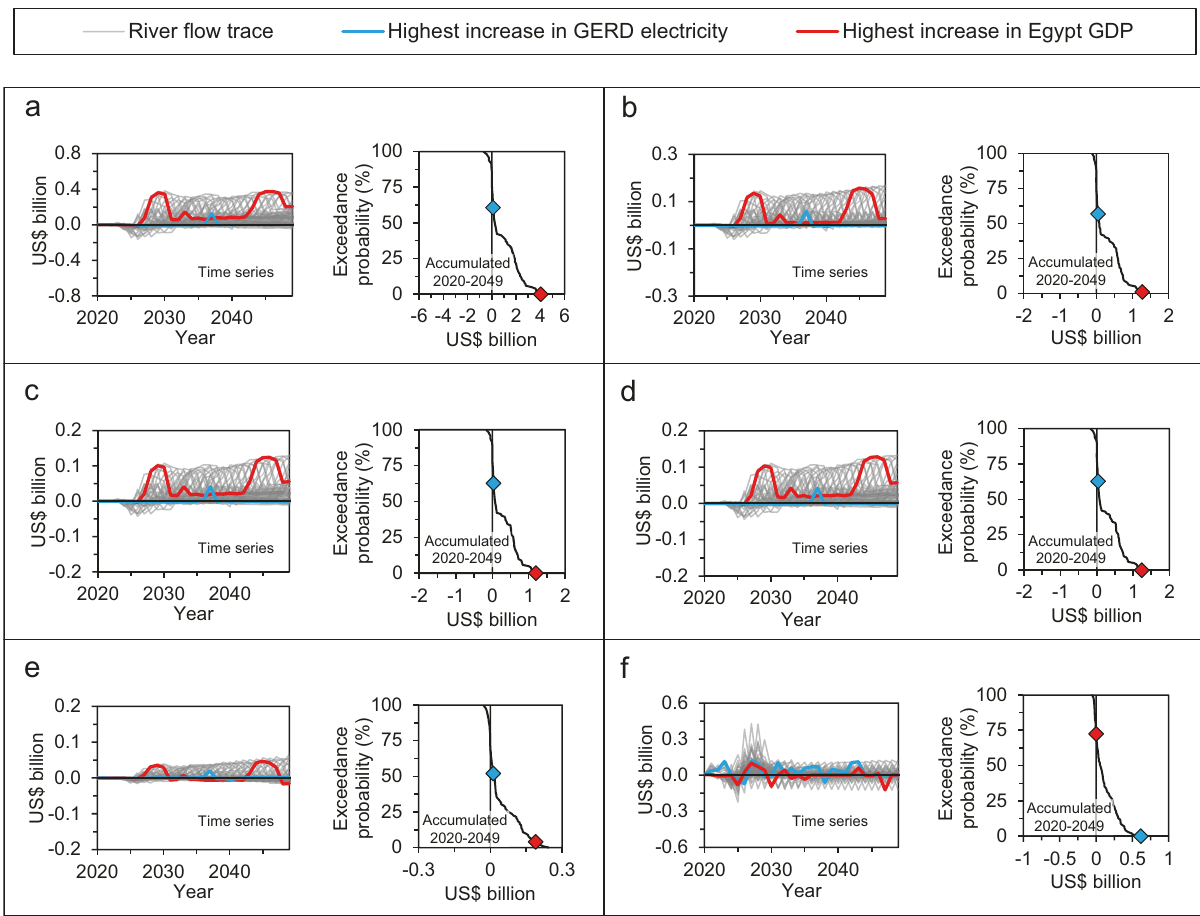
Fig. 4 Difference in simulated economic metrics of Egypt and Ethiopia between the coordinated operation and the Washington draft proposal. a Egypt ’ s GDP at market prices. b Egypt ’ s investment. c Egypt ’ s export. d Egypt ’ s imports. e Egypt ’ s government savings. f The fi nancial value of GERD electricity. Positive values indicate higher simulated results with the coordinated operation. The cyan- and red-colored points in the probability plots correspond to the cyan- and red-colored river fl ow traces, respectively. The results are discounted at a 3% rate. The results in panel ( f ) are based on Ethiopia ’ s current electricity export price to Sudan (US$ 0.05 per kWh). GDP gross domestic product, GERD Grand Ethiopian Renaissance